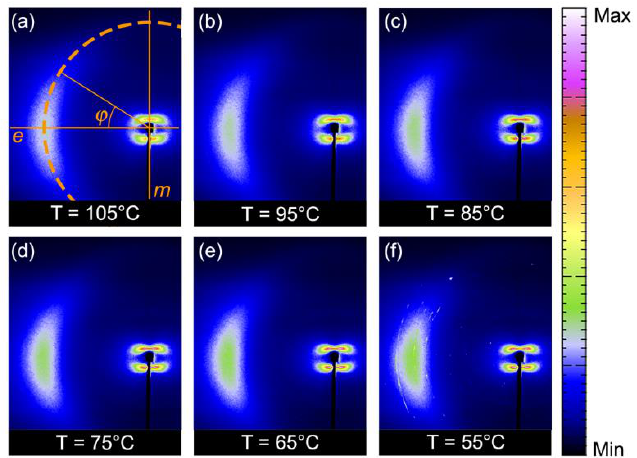
Figure 6. ( a – f ) WA XRD patterns taken in the nematic phase, aligned by a vertical magnetic field, at selected temperatures on cooling from the isotropic melt. Because of the pattern symmetry, only the left WA crescent is shown. In panel ( a ), lines m and e represent the meridional and equatorial axes, respectively, while the dashed arc indicates the measurement direction for the intensity profiles of the WA crescents as a function of the azimuthal angle ϕ . All patterns were background-corrected by subtracting the scattering from an empty capillary.